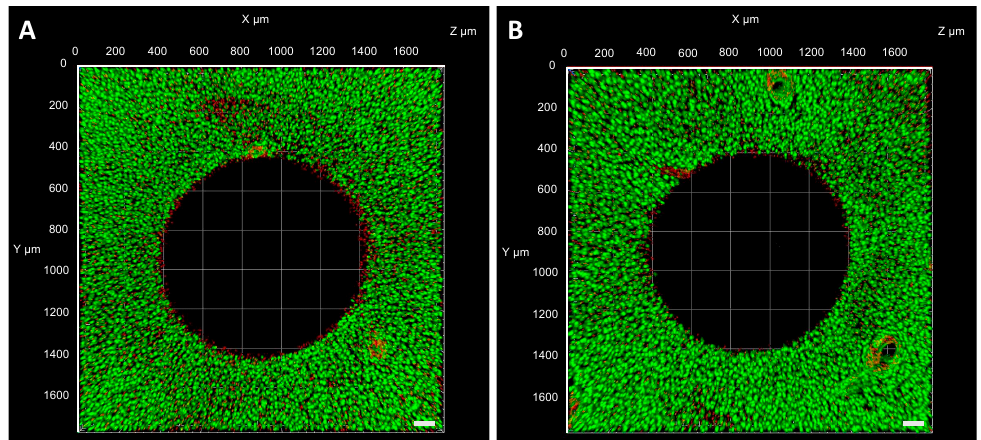
Figure 9. Representative live/dead images of ( A ) control and ( B ) DC EF treated cartilage explants following DC EF stimulation for 3 h (Scale bar = 100 μ m).